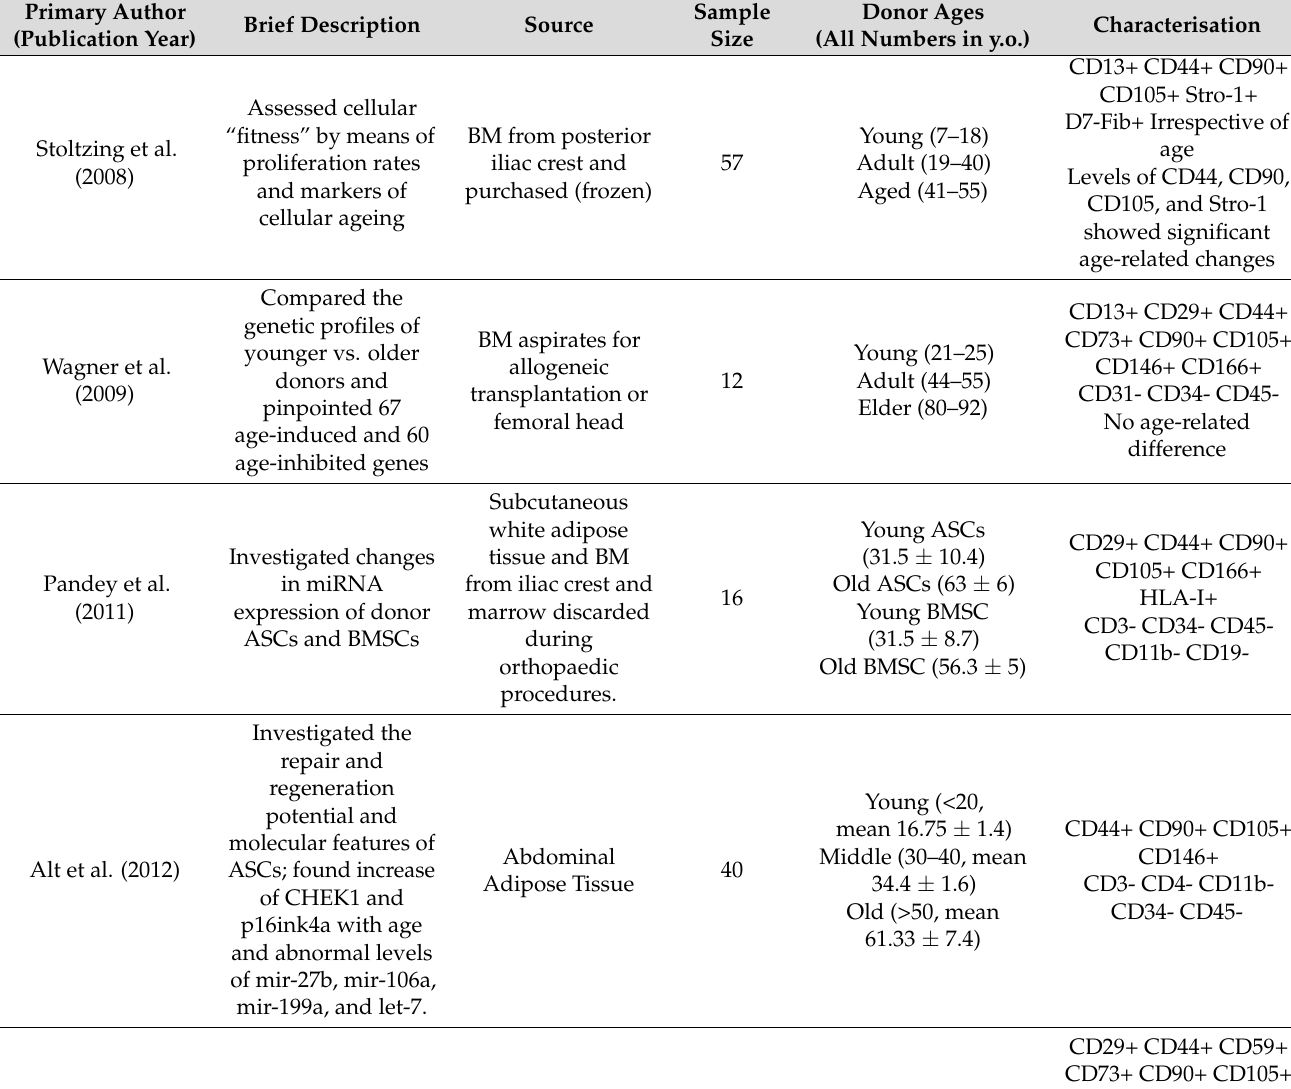
Table 1. Key characteristics of the included